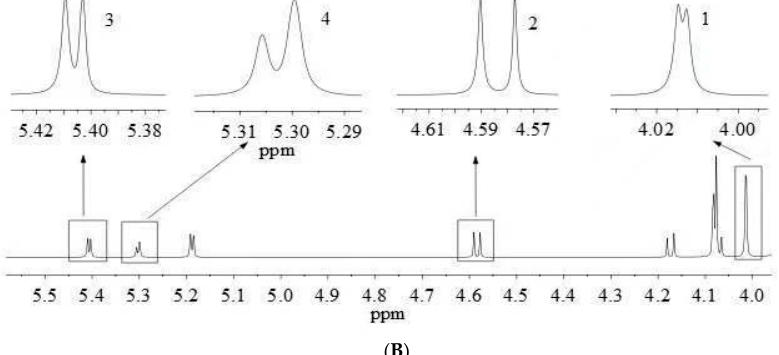
Figure 3. qNMR spectrum of YQFM at the spectral range from δ = 0.0 to 9.0 ppm with an enlarged view on the spectral range from δ = 4.0 to 5.5 ppm, measured with a 600 MHz spectrometer ( A ). Highlighted inserts show NMR peaks (top in sample) used for analyte quantitation, Numbers 1–4 correspond to fructose, glucose, sucrose and maltose, respectively ( B ). qNMR analysis is achieved by comparing the intensities of specific absorption peaks. Table 3. qNMR signal information (600 MHz, with MeOH-d 4 : D 2 O (50:50, v / v ) as solvent for compounds) for NMR resonances used within the 1 H-NMR experiments for sugars from YQFM quantitation.